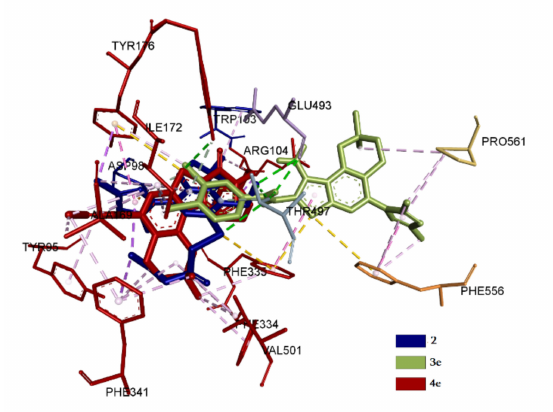
Figure 7. Superposition of 2, 3e and 4e in the central site of the active center of SERT.